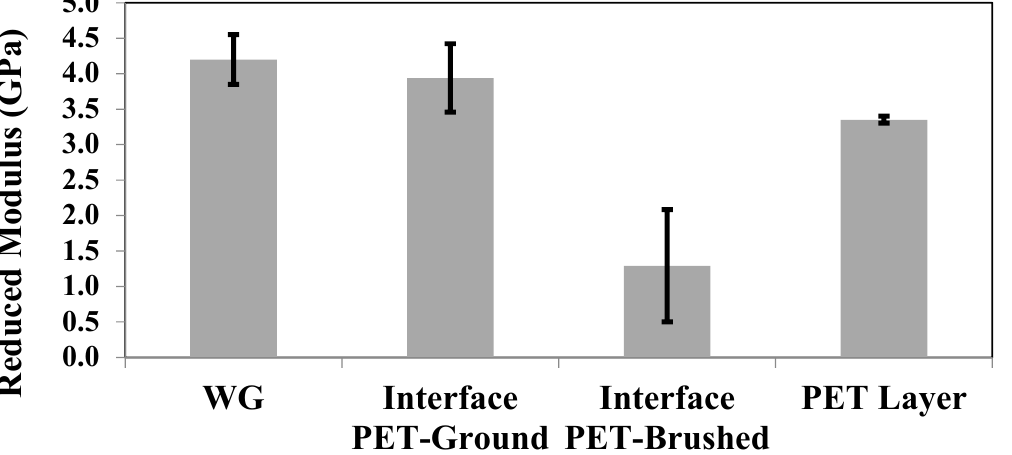
Figure 9. Nanoindentation modulus (reduced) of the cross-sectional samples.